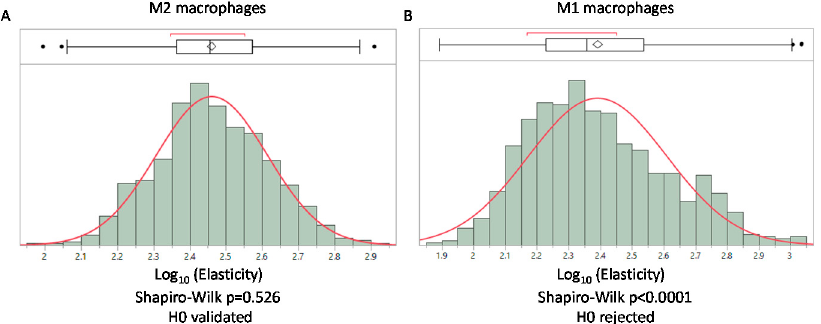
Figure 3. Distribution of elasticity values from AFM measurement on a collagen type I gel with macrophages polarized as M2 and M1. ( A ) log-normal distribution of elasticity for gels containing M2 macrophages. ( B ) Loss of the log-normal distribution when macrophages embedded in the gel are polarized toward M1. In each case a Shapiro–Wilk normality test is performed. (Histograms were obtained using the JMP software v14.2 SAS).